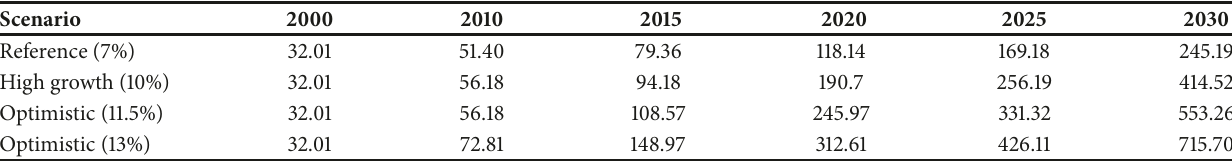
Table 2: Total projected energy demand